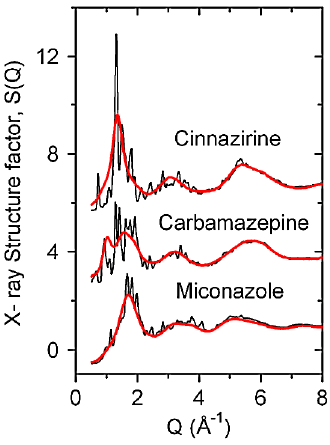
FIG. 4. The x-ray structure factors, S(Q), for three pure phar- maceutical drugs melted in the levitator with a laser and quenched to room temperature (thick red lines). The S(Q) functions are compared to the same starting materials melted and allowed to cool in a copper hearth (thin black